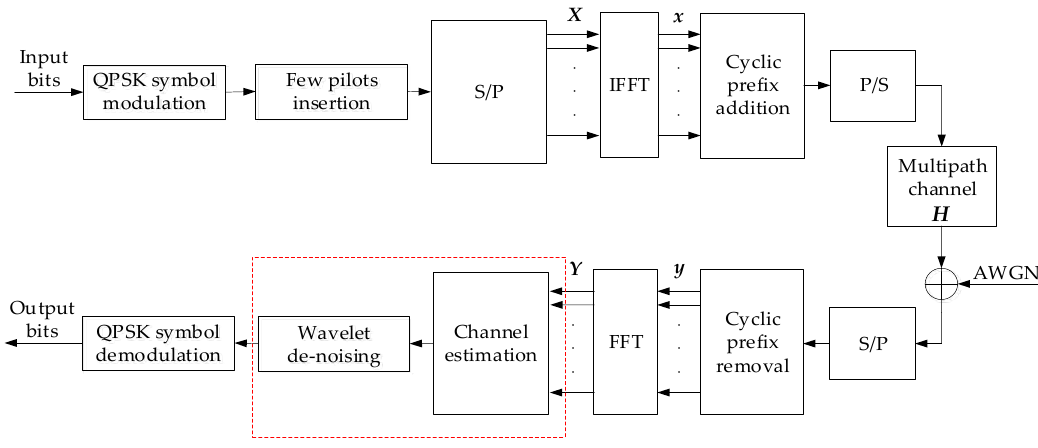
Figure 1. System model of the wavelet-orthogonal frequency division multiplexing (OFDM) system.